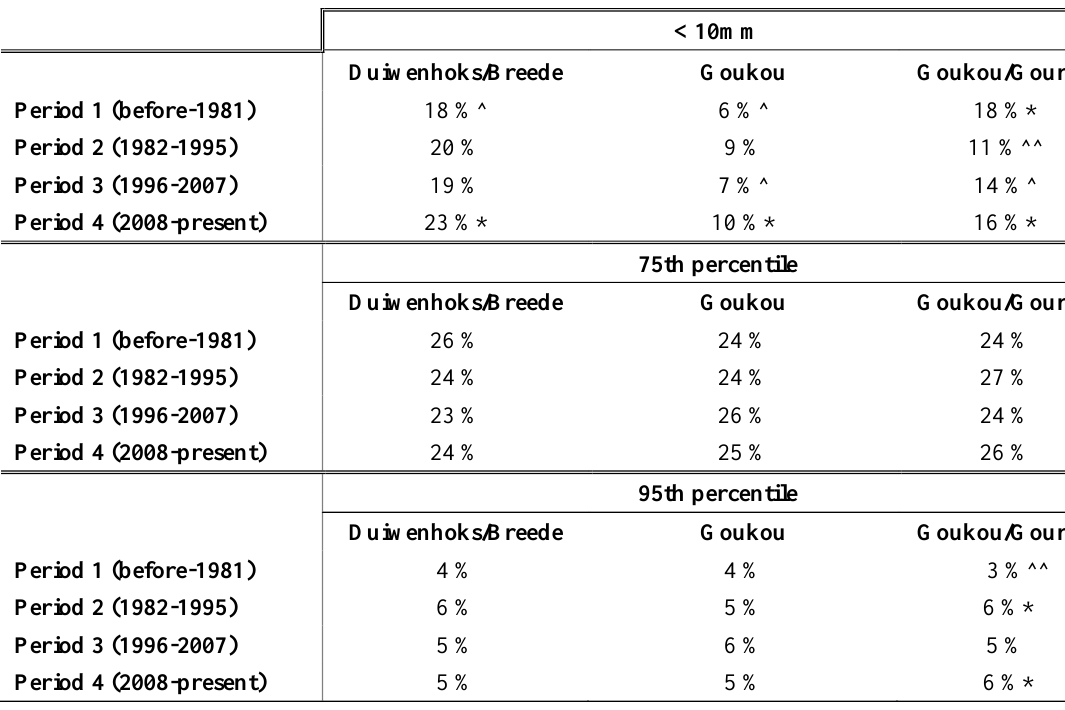
Table A3.4: Monthly rainfall according to three ‘extreme’ categories ((less than 10mm; 75th percentile; 95th percentile) divided up into catchment locations. Significance was tested between each time period for each category and group. Where significant, the t-test statistic was greater than 1.96 (corresponding p-value of less than 0.05) and hence was significant at the 95 percent significance